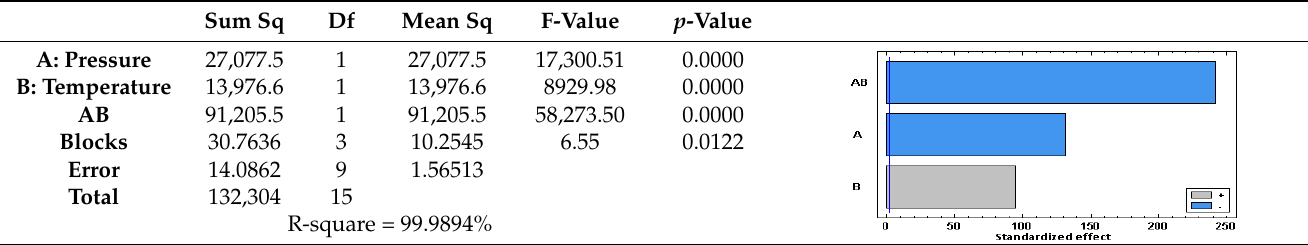
Table 2. ANOVA table and Pareto chart for quadratic model of swelling of TPU in the SSI with MLE. Sum Sq Df Mean Sq F-Value p -Value